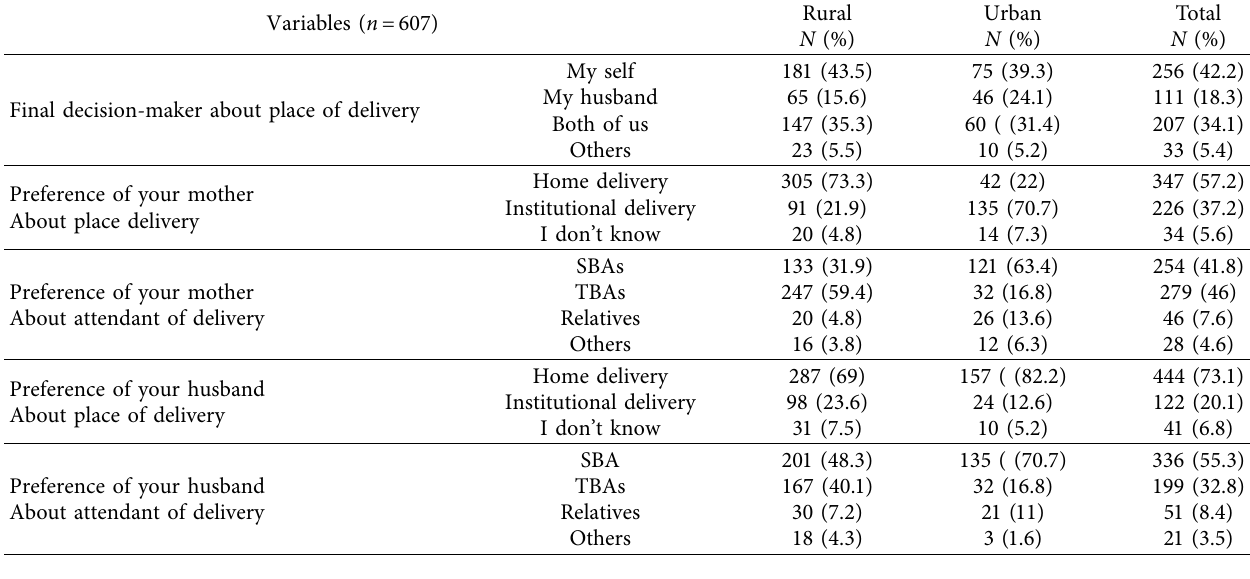
Table 4: Preferences of the respondents, their husbands and mothers about the place, and attendants of delivery during their last pregnancy in the Kembata Tembaro zone, 2020.